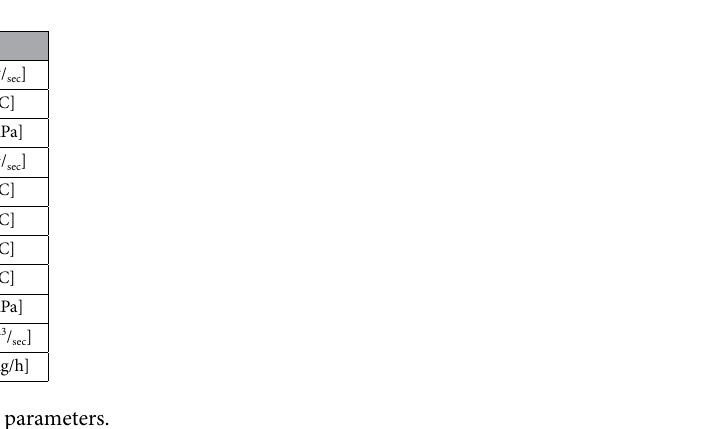
Table 1. Average combustion